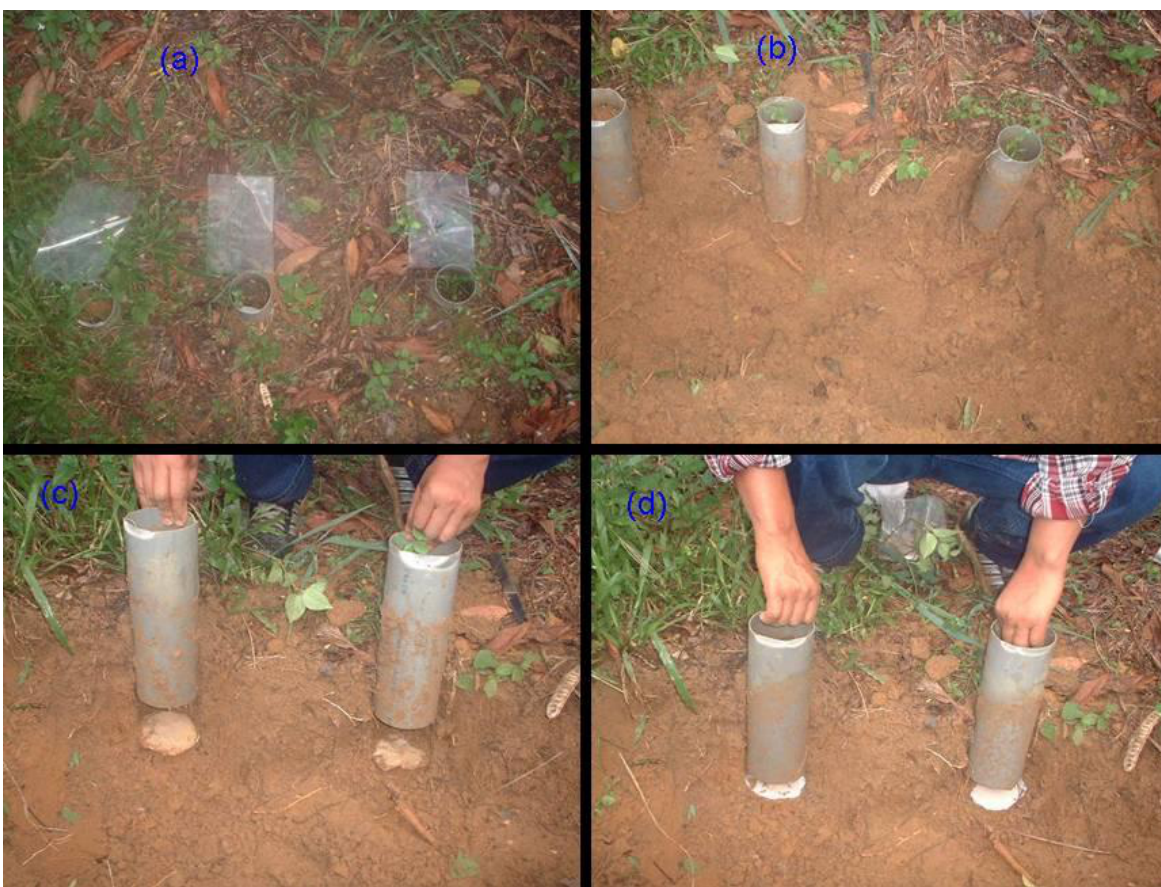
FIGURE 3. Sampling procedure showing (a) a view of the PVC tubes as inserted and sampling bags just before sampling, (b) tubes after excavation of surrounding soil showing position of resin bags, (c) old resin bags removed, and (d) replacement of old resin bags with fresh